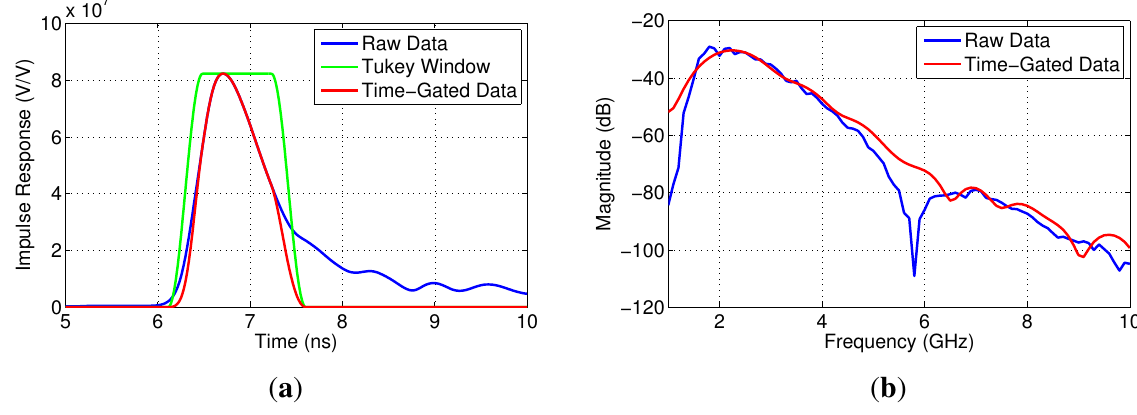
Figure 13. The results of time-gating for one of the five transmission measurements.